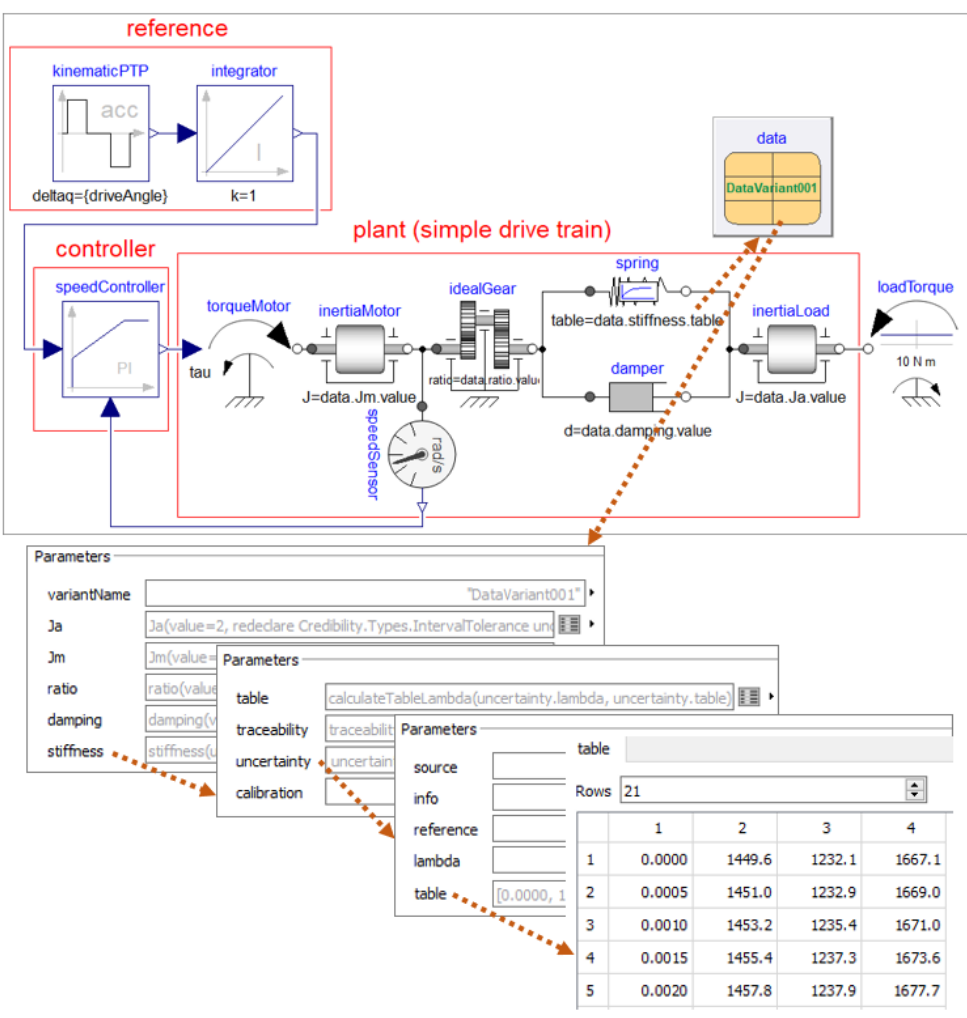
Figure 8. A screenshot of component Credibility.Examples.SimpleControlledDriveNonlinear.- SimpleControlledDrive_original , which is a model that can be simulated, consisting of the drive train together with a reference, controller, data values and a load torque. Additionally, the parameter menus are shown, which define the uncertainty table of the spring stiffness. The first column of